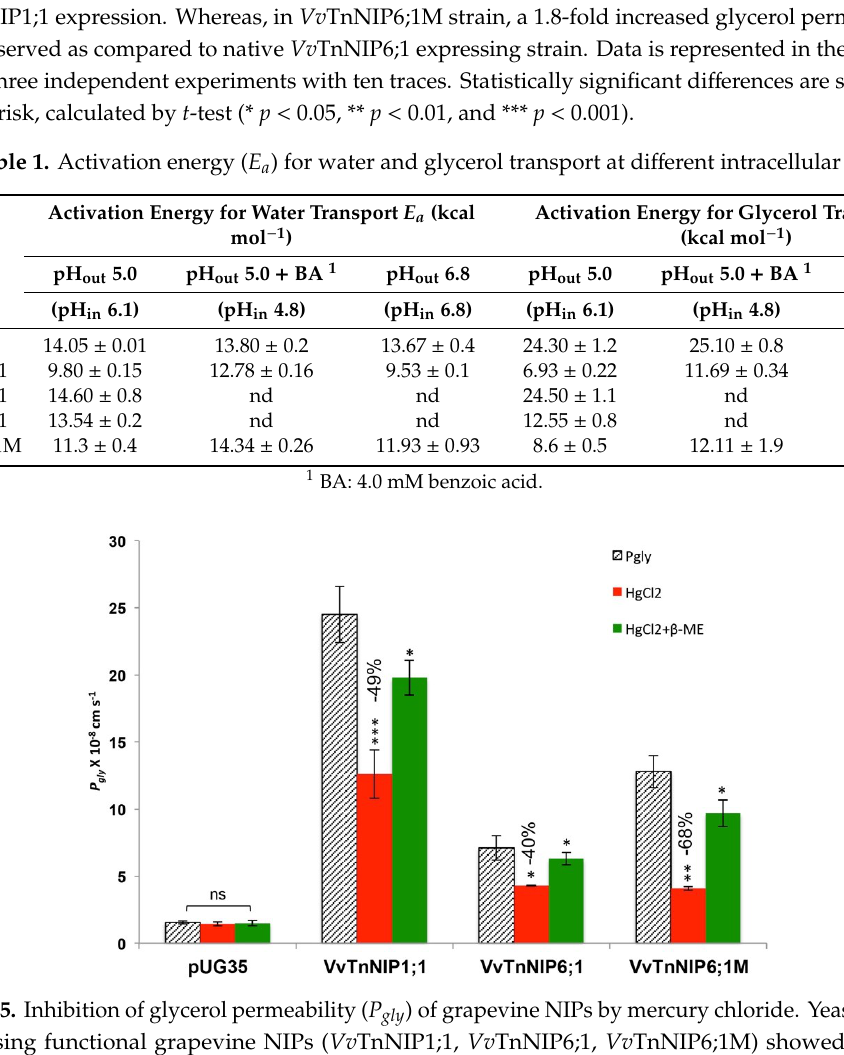
Figure 4. Water ( P f ) and glycerol ( P gly ) permeability coefficients measurement. The permeabilities were measured in yeast strains expressing grapevine NIPs and empty vector pUG35 at 23 °C and pH 5.0. ( A ) Expression of Vv TnNIP1;1 resulted in 1.7‐fold enhanced water permeability, whereas the other NIPs could not increase the water permeability. C‐terminal extension in Vv TnNIP6;1M homolog slightly enhanced the water permeability. ( B ) A 15‐fold improved glycerol permeability was observed